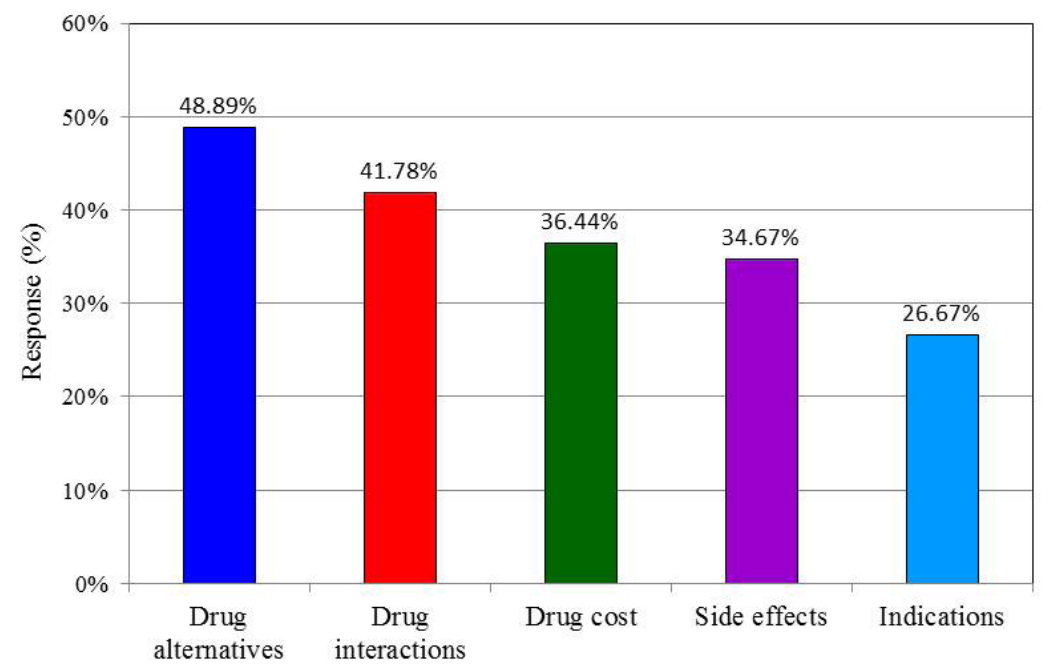
FIGURE 2 - Types of drug information requested from pharmacists by hospital’